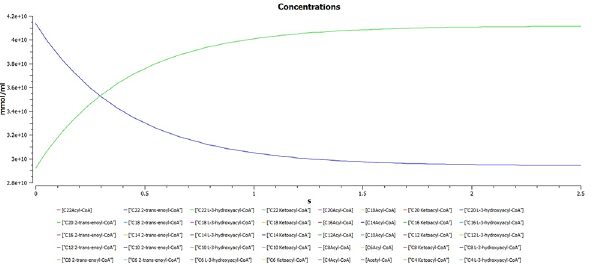
Fig 9. Simulation plot was generated depicting the change of Succynl CoA (SCoA) in TCA cycle with respect to time. (a) A plot of change of Succinyl CoA concentration with time for a time period of 1000 seconds (b) A plot of Succinyl CoA concentration with time for a time period of 2.5